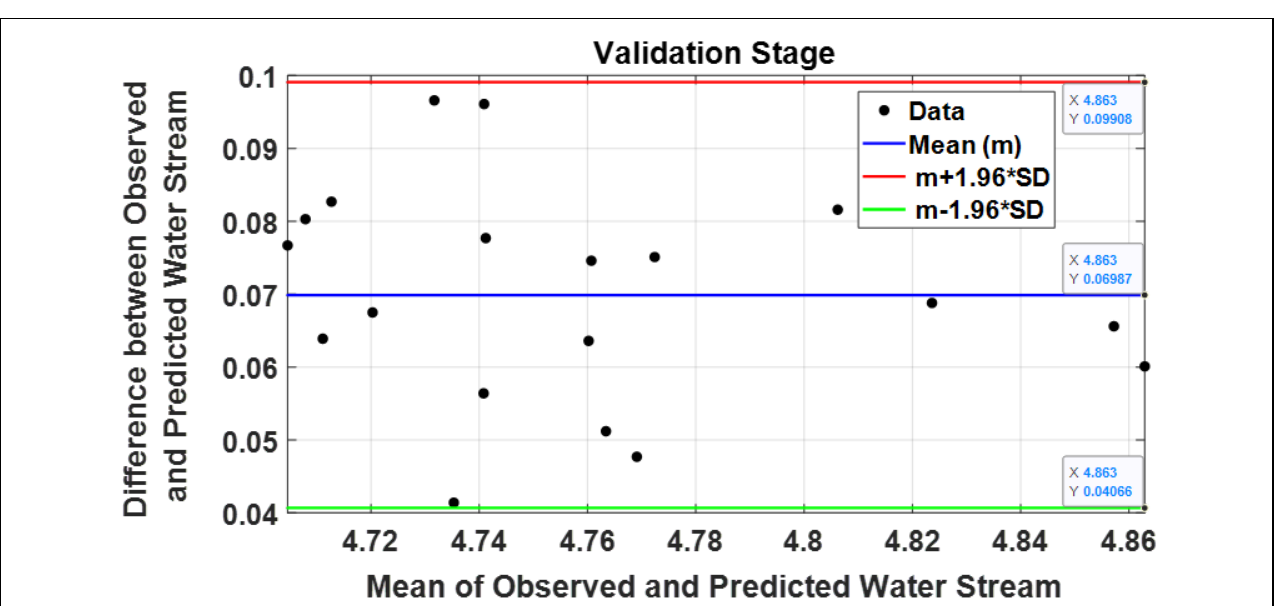
Figure 10. Bland – Altman plot of the integrated model in the validation stages. Figure 10. Bland–Altman plot of the integrated model in the validation